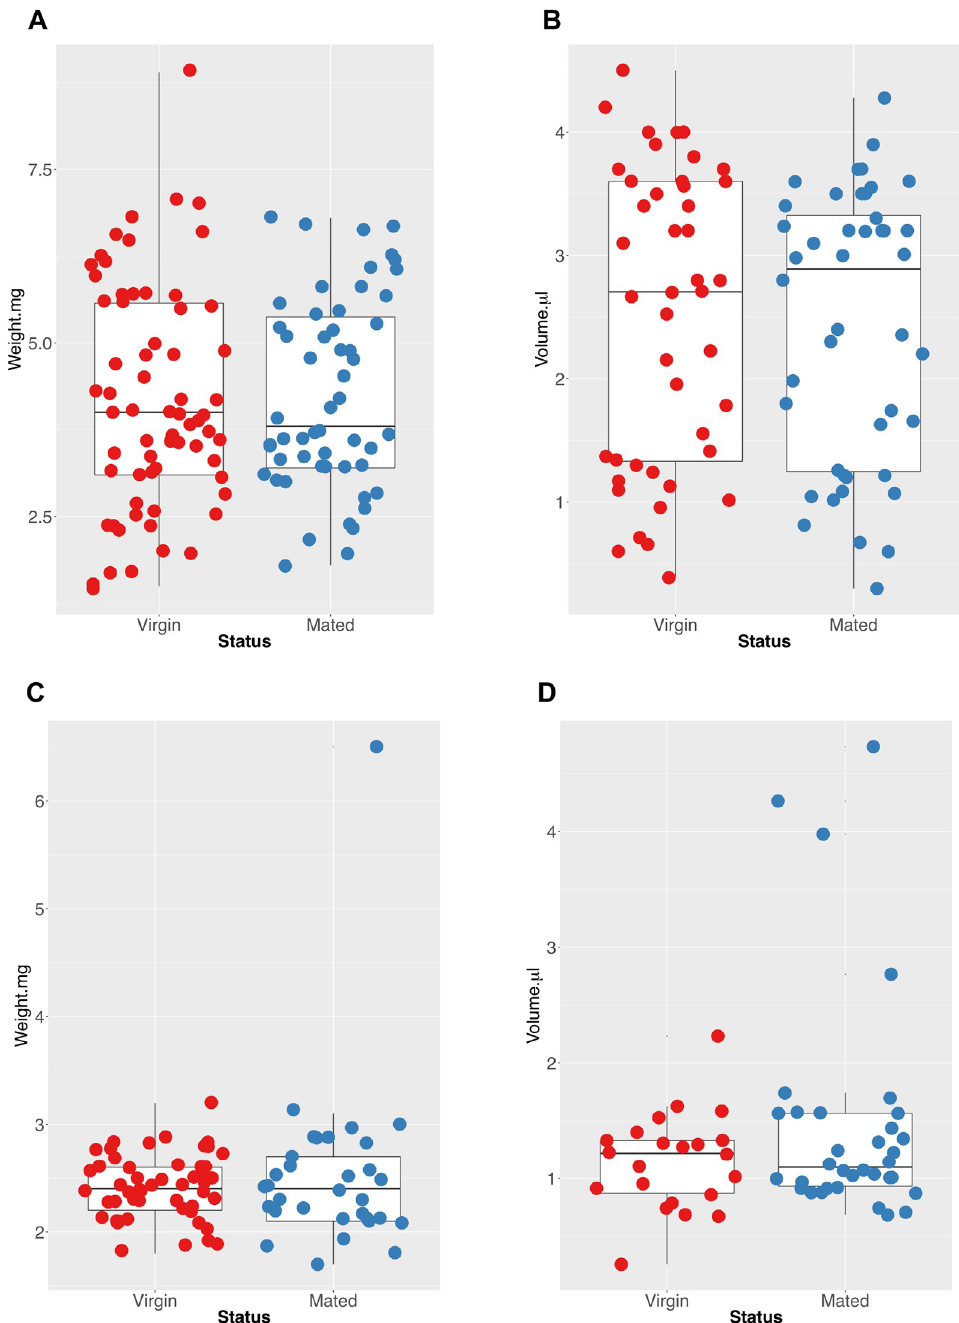
Fig 2. Mated and virgin females take similar bloodmeal volumes and digest to the same level after 24 hours. Boxplots indicate the median and 25-75th percentiles. Examining the (A) weights of blood-fed mosquitoes as well as their (B) hemoglobin levels using the Drabkin reagent shows blood-fed virgin and mated females take in the same the volume of blood at the time of feeding (0 hours post blood-meal). Furthermore, they digest to a similar level. Boxplots indicate the median and 25-75th percentiles. Examining the (C) weights of blood-fed mosquitoes immediately after a bloodmeal as well as their (D) hemoglobin levels using the Drabkin reagent reveals blood-fed virgin and mated females have digested blood to the same level as each other 24 hours post blood-meal. Boxplots indicate the median and 25-75th percentiles.